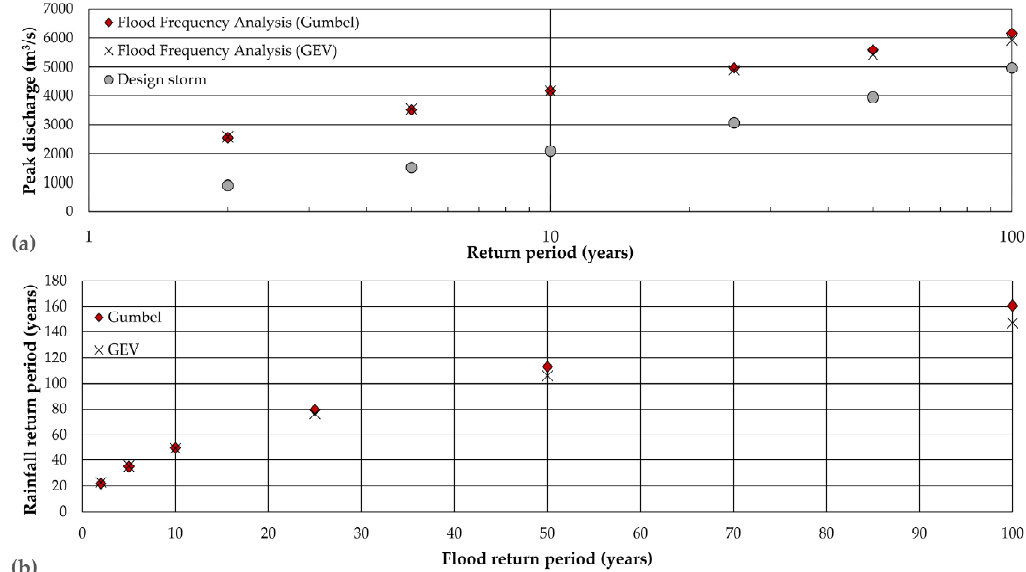
Figure 7. Comparison of the two approaches (design storm and continuous simulation and flood frequency analysis) in terms of ( a ) return period and peak discharges, and ( b ) relationship of rainfall return period to flood return period. Table 6. Comparison of peak discharges estimated using the two approaches.